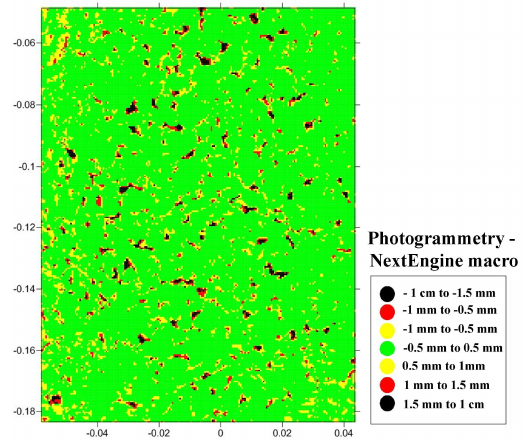
Figure 4. Quantitative comparison between the 3D models of the same asphalt area obtained by Laser Scanner survey (macro mode) and by Photogrammetry. The values demonstrate that in this test the photogrammetric approach induced a smoothing effect on the “peaks and valleys” of the surface; green points are within the accepted tolerance.